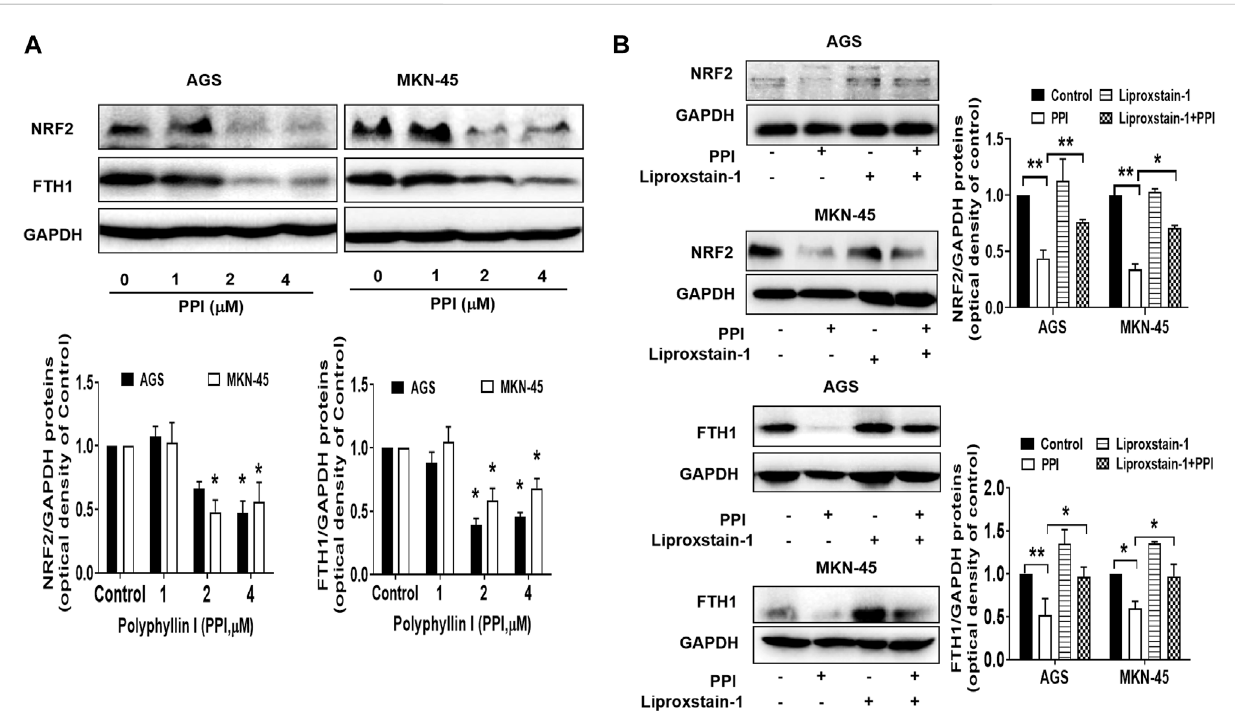
FIGURE 6 Effects of PPI on the expression of NRF2 and FTH1 in gastric cancer cells. AGS and MKN-45 cells were cultured and treated with PPI at various concentrations for 24 h, and then the protein levels of NRF2 and FTH1, without (A) or with (B) Liproxstain-1 treatment, were detected using Western blot assays. Data are presented as mean ± SD, while p values were determined using one-way ANOVA ( *p < 0.05, and **p < 0.01, as